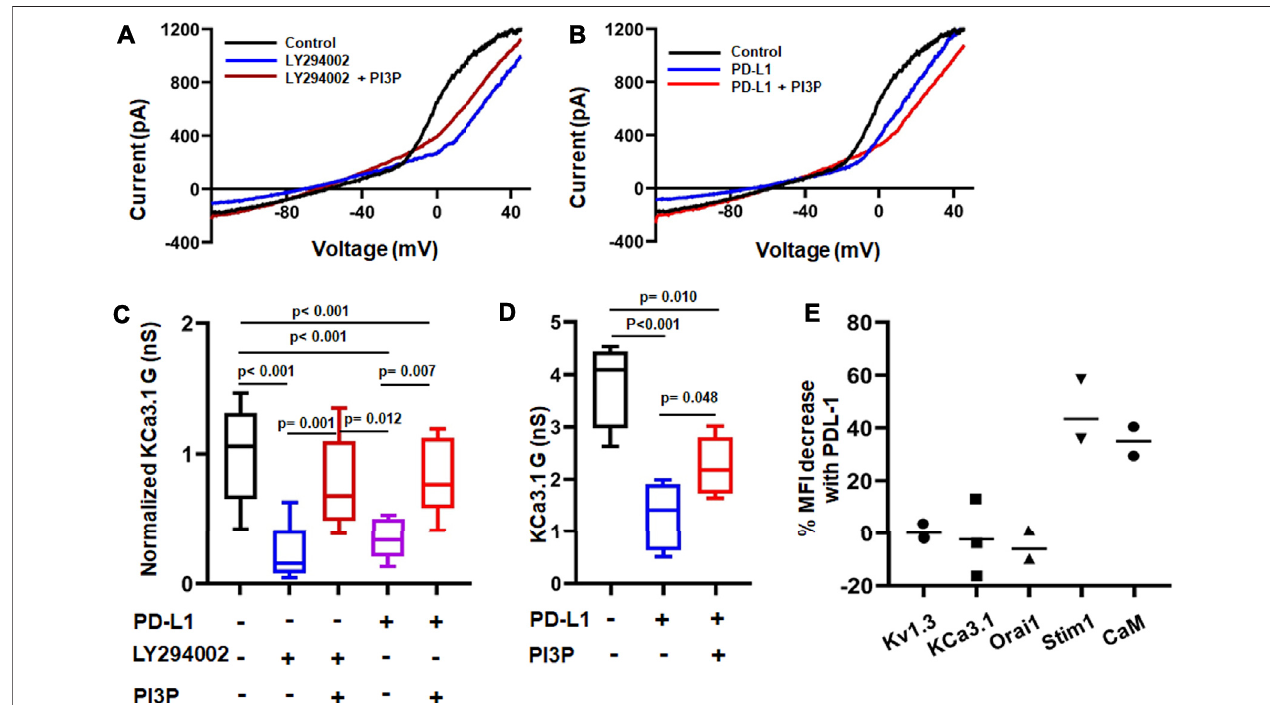
FIGURE6| Differential time-dependentinvolvementofPI3Kand calmodulinon PD-L1mediatedinhibitionofKCa3.1channels. (A,B) Representativerecordingsof KCa3.1 channels in activated CD8 + PBTs from HDs showing the effect of the PI3K inhibitor LY294002 (10 µM) +/ − phosphatidylinositol-3 phosphatase (PI3P) (100 nM) (A) andPD-L1(PD-L1-Fc,10 μ g/ml)+/ − PI3P(100 nM) (B).(C) SummaryofthepharmacologicalmodulationofKCa3.1channelsbyLY294002andPI3Pintheabsence and presence of plate bound PD-L1 in activated CD8 + PBTs of HDs. Cells were activated using anti-CD3/CD28 antibodies for 72 h. Cells were perfused with LY294002 for 15 min followed by patch clamp recordings with and without PI3P, delivered intracellularly via patch pipette ( n (cid:1) eight to nine cells per group from 3 HDs). All KCa3.1 conductance (G) values are normalized to the average G of the control group (drug-free). (D) KCa3.1 G measured in absence or presence of PD-L1 in activated CD8 + PBTs of HDs. Cells were treated with plate-bound PD-L1 (PD-L1-Fc, 10 μ g/ml) and activated using anti-CD3/CD28 antibodies for 120 h PI3P was deliveredintracellularly via thepatchpipetteduringtheelectrophysiologicalexperiments(drug-freecontrol).Cellswereheldat − 70mV, n (cid:1) fourto fi vecellspergroupfrom one HD. The values in panel (C,D) are represented as box and whiskers plot. The lower and upper bound of the box represent 25 th and 75 th percentiles respectively. Medianvaluesareshownashorizontalline.Theloweranduppererrorbarsrepresents10 th and90 th percentilerespectively. (E) Percentagechangeinmean fl uorescence intensity (MFI) of ion channels (Kv1.3, KCa3.1, Orai1, Stim1) and Calmodulin (CaM) measured using fl ow cytometry. Each dot represents an individual HD and the horizontalblacklinerepresentsthemeanvalue.Datainpanel (C) wereanalyzedbyOneWayANOVA( p < 0.001)followedbyHolm-Sidak ’ s posthoc analysis.Datain (D) were analyzed by One way ANOVA followed by Holm-Sidak ’ s post hoc